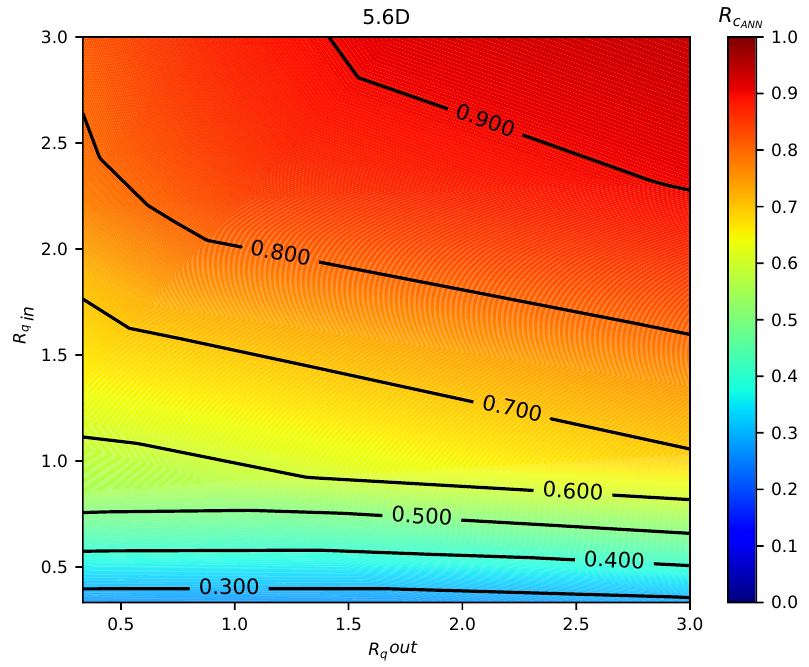
Figure 3. Predicted R c